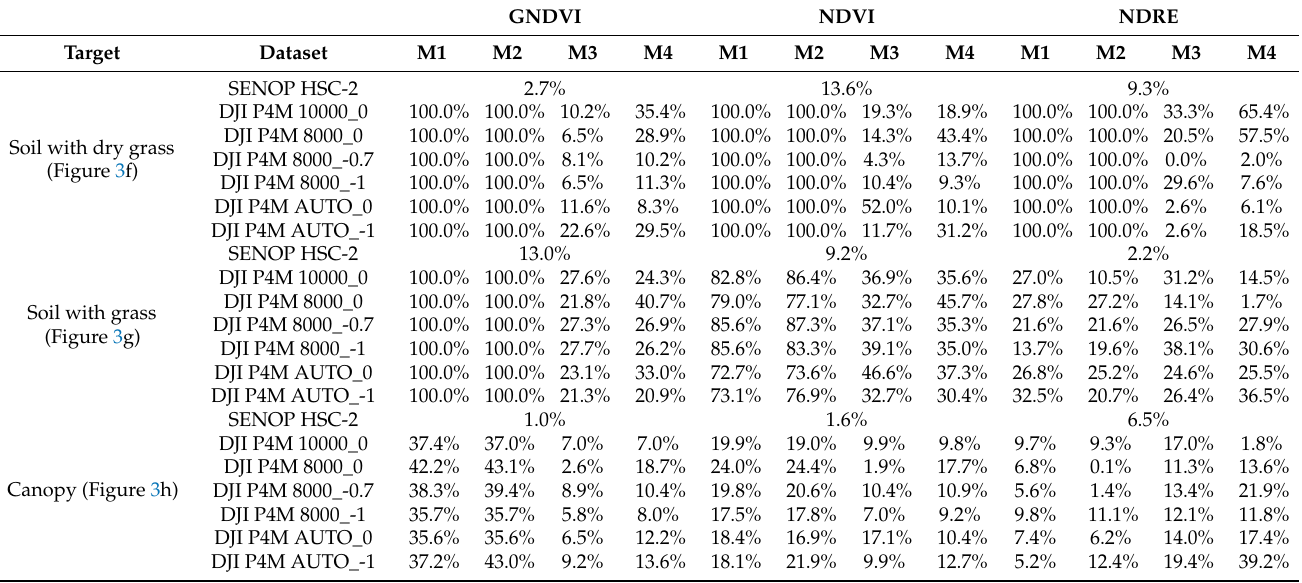
Table 4. Results of the comparison between 3 vegetation indices (GNDVI, NDVI, NDRE) calculated for canopy, soil with grass and soil with dry grass targets using SENOP HSC-2 hyperspectral and DJI P4M multispectral cameras with 6 different exposure settings and 4 radiometric calibration approaches versus the VIs obtained using the GER 3700 reference spectroradiometer. The table reports the results as percentage error (PE) (%). GNDVI NDVI